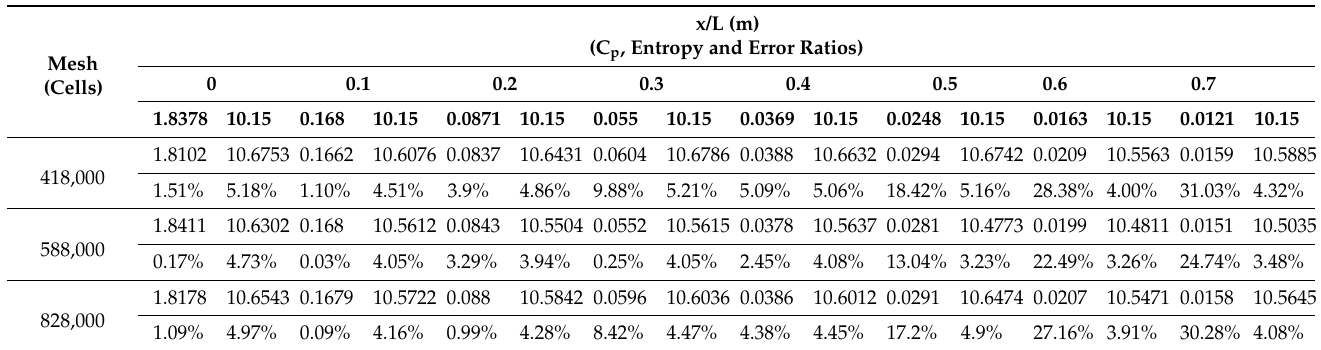
Table 4. Grid independency study of three levels of different mesh with error ratios for pressure coefficient and entropy at a far-field distance is 12 m.